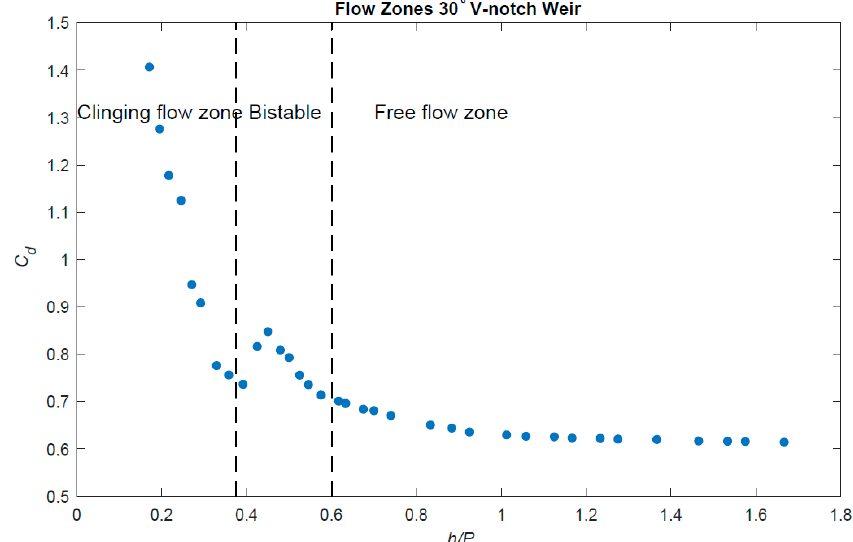
Figure 6. Discharge coefficient ( C d ) plotted against the ratio h/P for the data of the 30° weir observed.